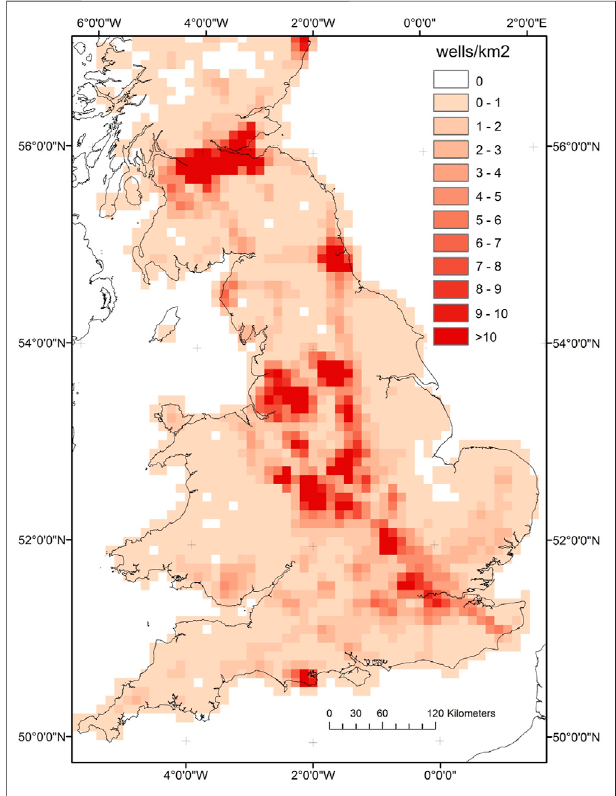
FIGURE 3 | Borehole density of all boreholes held by the BGS with a TD between 30 and 300 m.